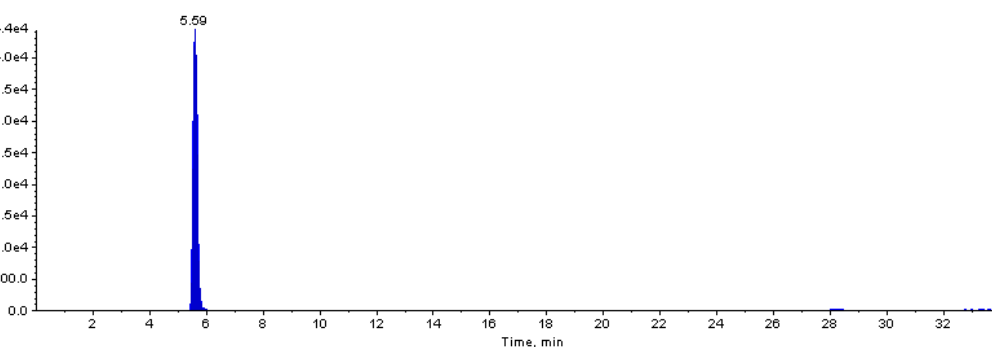
Figure 1. HPLC-MS chromatogram shows identification (two MRM transitions m / z 153 → 109 and 153 → 91) and determination of concentration of protocatechuic acid (PCA) in aqueous extract of Hibiscus sabdariffa (AEHS). PCA was detected at retention time (RT): 5.59 min and quantified using an external calibration method with standard PCA (94.1 µg/g dry weight of Hibiscus calyces). Table 1. Anti-HSV-2 activity and cytotoxicity of PCA and AEHS. Compound